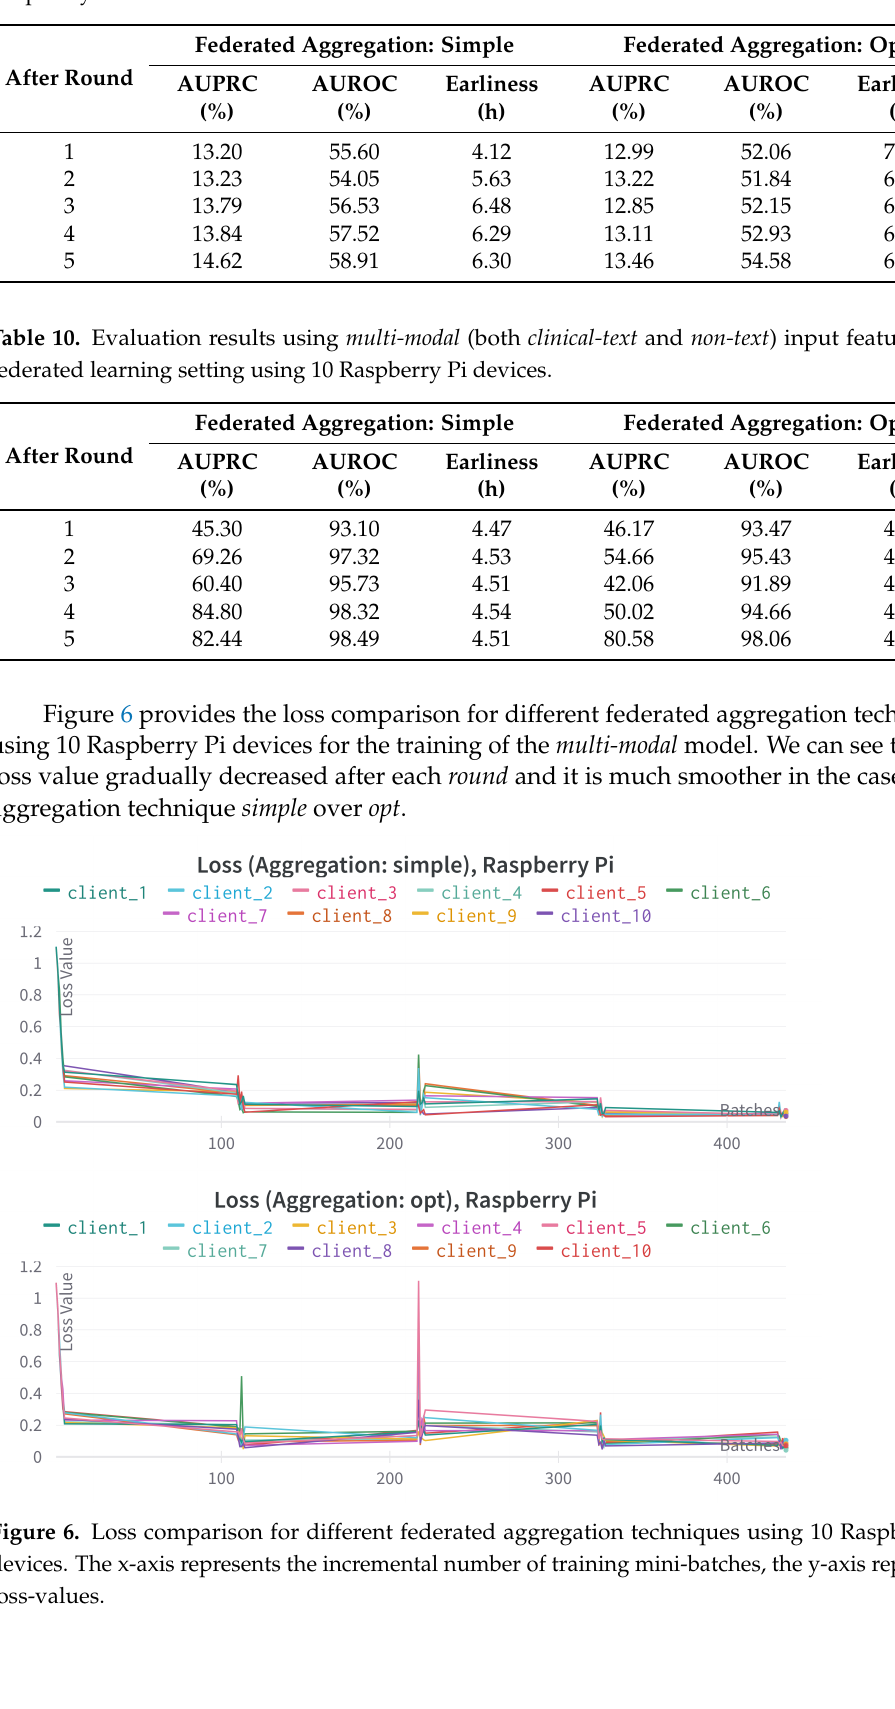
Table 9. Evaluation results using clinical-text input features in a federated learning setting using 10 Raspberry Pi devices.